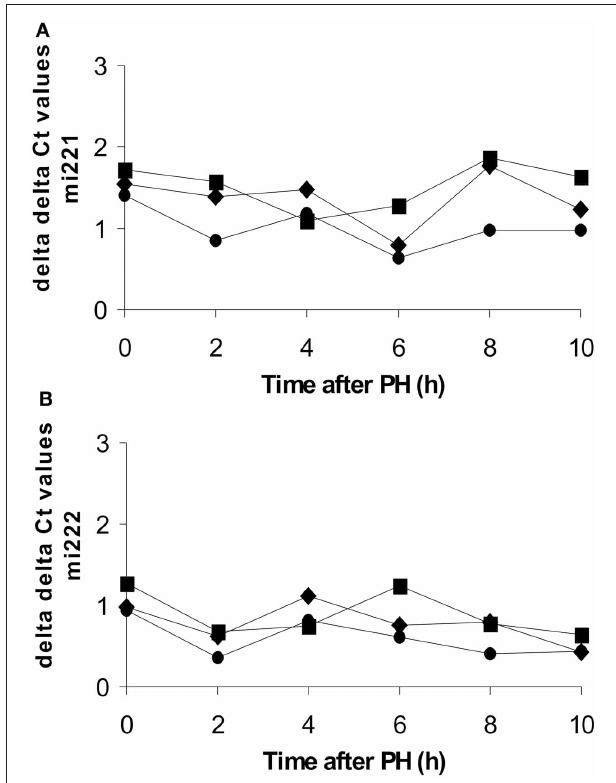
FIGURE 7 | Abundances of miRNA221 or miRNA222 in total RNA preparations from rat liver during or at different times after partial hepatectomy as determined by qPCR. Data are expressed as (cid:2)(cid:2) Ct values for miRNA221 (A) or miRNA222 (B) using 4.5 S-RNA (diamonds), U6-snRNA (squares), or β -actin mRNA (full circles) as internal standards. Each data point represents the mean of the results of 2 replicates performed on a sample of total RNA obtained from one individual animal per time